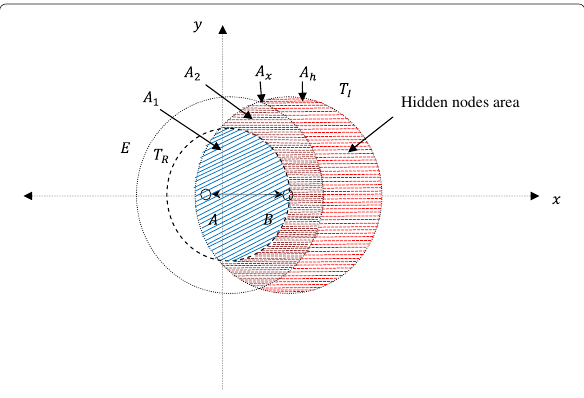
Fig. 5 Transmission, reception, and interference